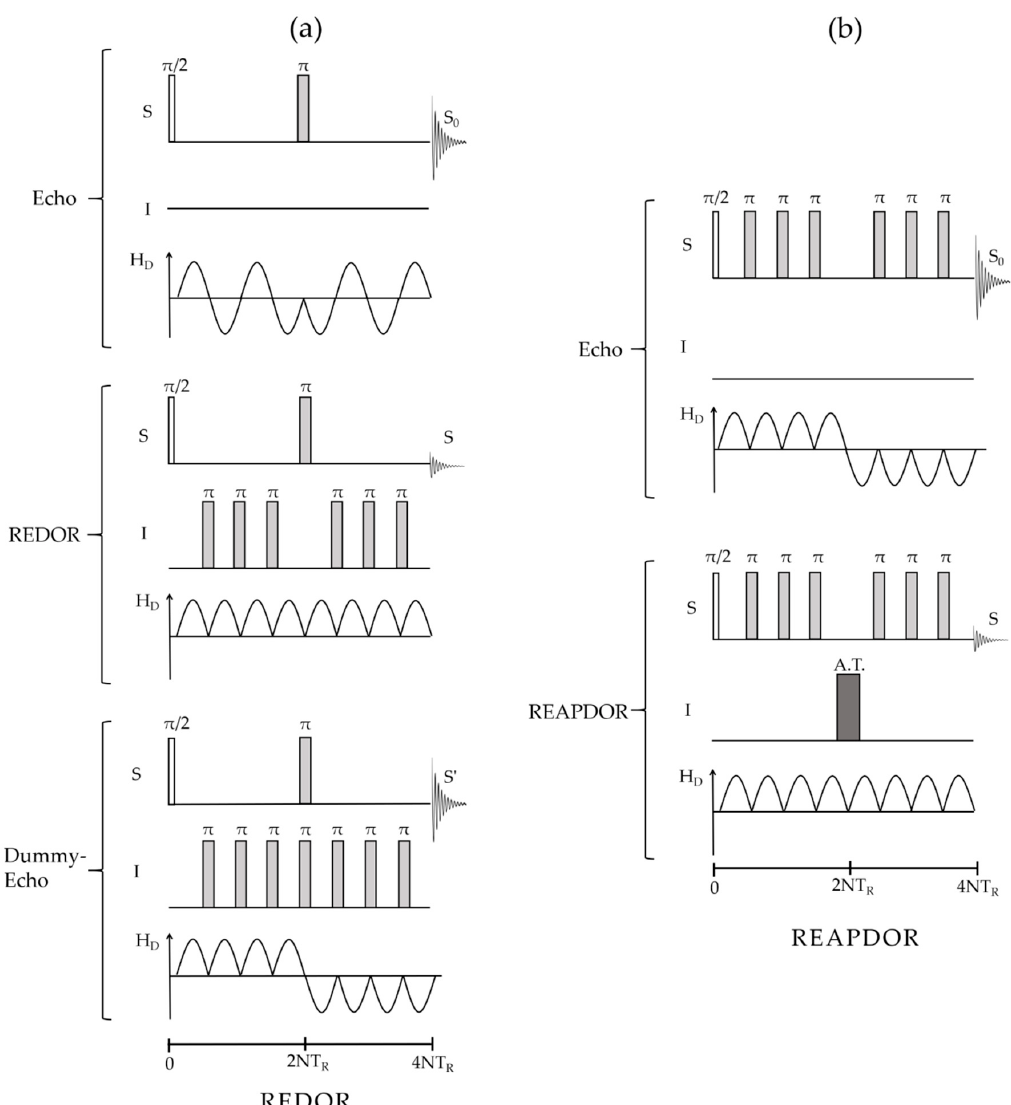
Figure 11. ( a ) Pulse sequence elements of the standard compensated REDOR experiment. The evolution of the dipolar Hamiltonian is shown below each pulse sequence element. Top: spin-echo experiment on the observed S-channel to acquire the reference intensity S 0 . Middle: echo experiment with dipolar recoupling, resulting in the intensity S . Bottom: “dummy” echo experiment producing a correction S ’ to the dephased intensity to account for pulse inaccuracies and finite pulse length effects. ( b ) Pulse sequence for the rotational echo adiabatic passage double resonance (REAPDOR) experiment used for recoupling of the direct dipolar interaction to quadrupolar nuclei. Here, an adiabatic transfer (AT) pulse inverts magnetization on the I-channel.